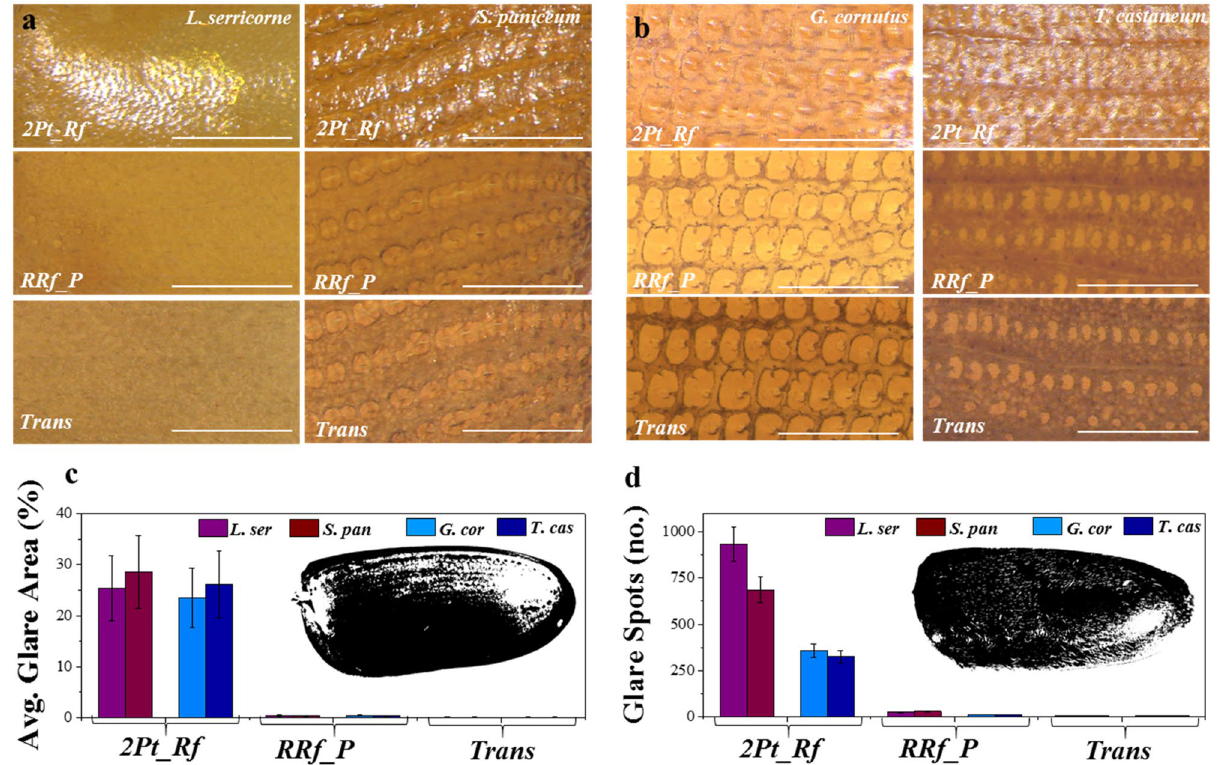
Figure 2. Comparing three different illumination systems. Images of elytra under three different lighting conditions (top: 2Pt_Rf , middle: RRf_P and bottom: Trans ), for two different families (a) Anobiidae, with species L. serricorne (1st column) and S. paniceum (2nd column) and ( b) Tenebrionidae with species G. Cornutus (3rd column) and T. castaneum (4th column). All images were captured at 50x magnification, with the scale bars being 250 µm. The glare in images due to 2Pt_Rf illumination is evident. The RRf_P and Trans systems provide a much better alternative that significantly reduces glare, which obstruct elytral patterns. The extent of glare has been quantified as (c) percentage of elytra area obstructed due to glare, (d) number of glare spots (i.e. artifacts) due to setae when compared against three different illumination systems for two different families, which further highlights the advantages of RRf_P and Trans